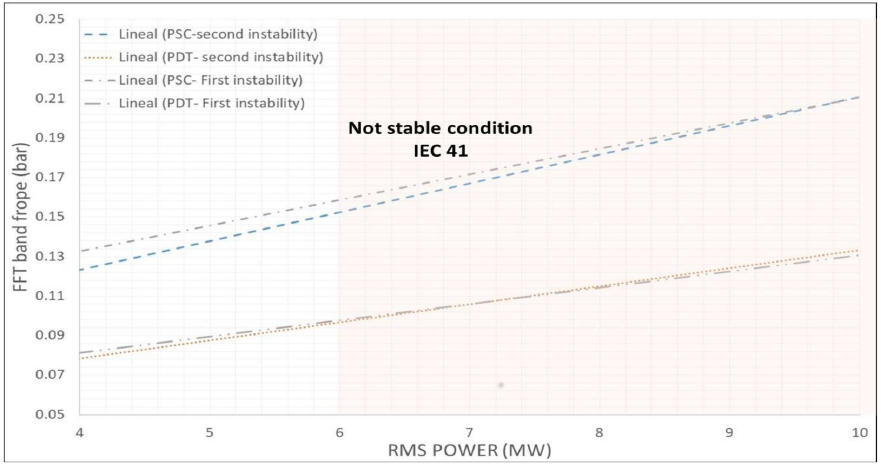
Figure 17. Optimized acquisition strategy. Repeatability of the